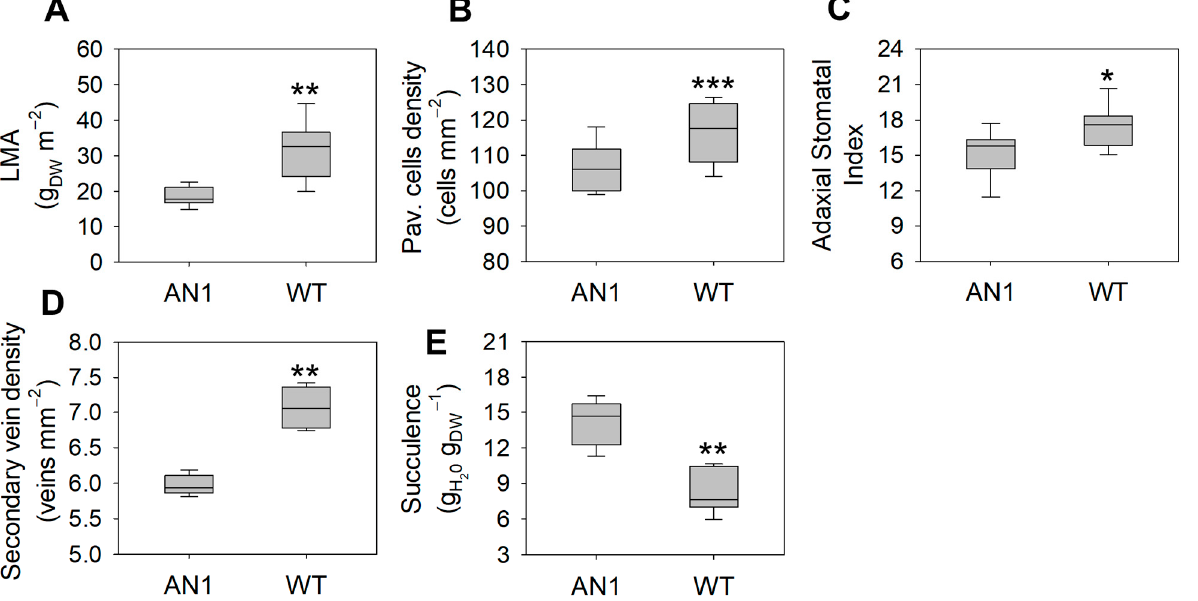
Figure 5. Leaf anatomical and morphological traits in AN1 and WT. ( A ) Leaf mass per area; ( B ) Pavement cells density; ( C ) Adaxial stomatal index; ( D ) Secondary vein density; ( E ) Succulence. Asterisks indicate significant differences according to ANOVA (* p < 0.05; ** p < 0.01; *** p < 0.001).